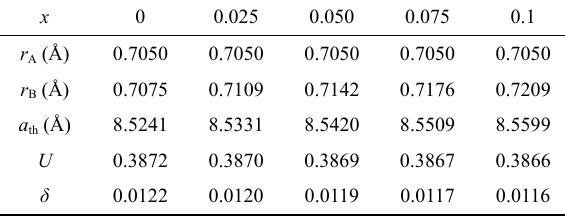
Table 3 Variation of bond length, tetrahedral edge length, the shared octahedral edge length, the unshared octahedral edge length, and X-ray density